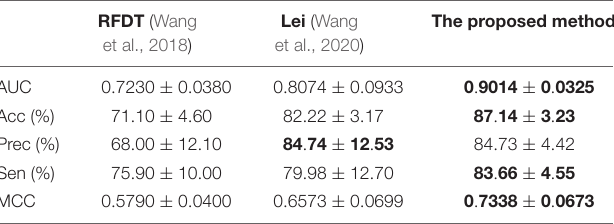
TABLE 8 | Performances of different methods on NR–drug interaction datasets. RFDT (Wang et al., 2018)